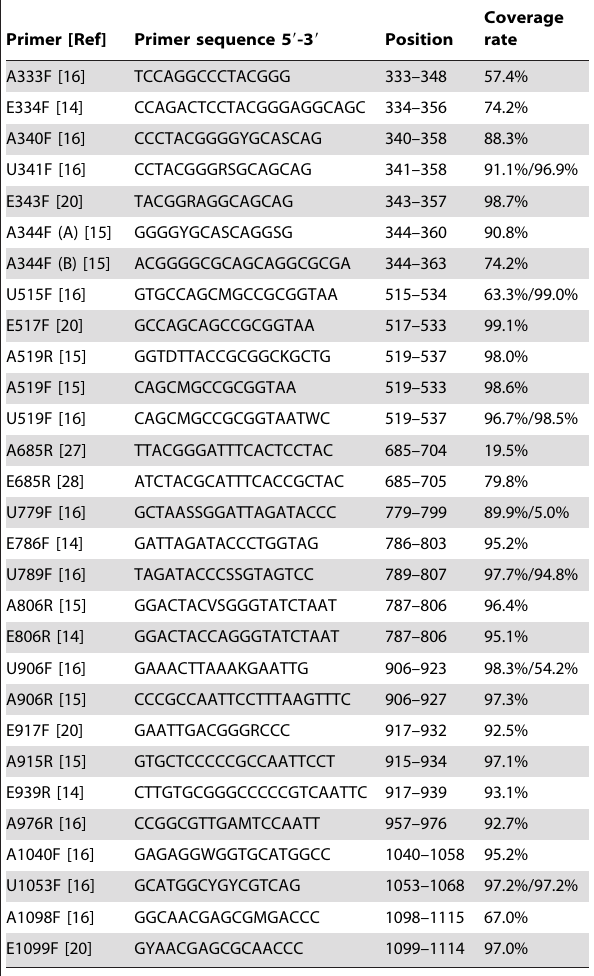
Table 3. Coverage rate of known